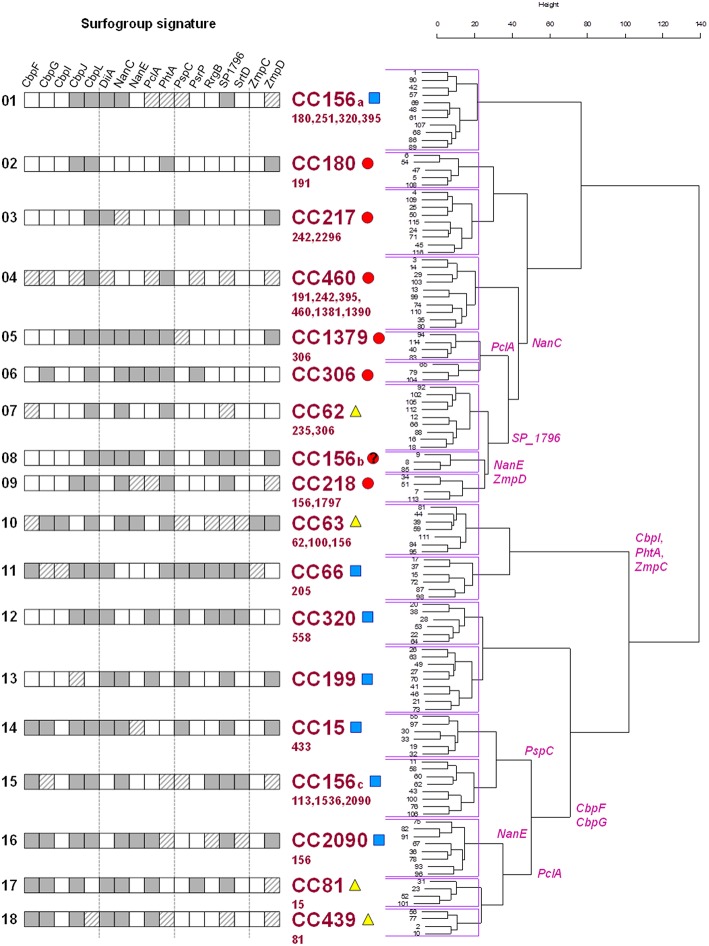
Hierarchical clustering of surfotypes and correlation to clinical behavior. Surfogroup signature cells: dark gray (presence/full feature match homogeneity >60%); white (absence/truncated feature match homogeneity >60%); dashed (match homogeneity < 60%). The surfogroup clades are labeled with the most abundant clonal complex together with pathogenic tendency: primary invasive (red circles), opportunistic invasive (blue squares), and non-invasive (yellow triangles). Minority clonal complexes are listed in smaller font size below. Specific protein families responsible from branching (>80% surfotypes in a branch, < 20% surfotypes in the other) are labeled in the tree.